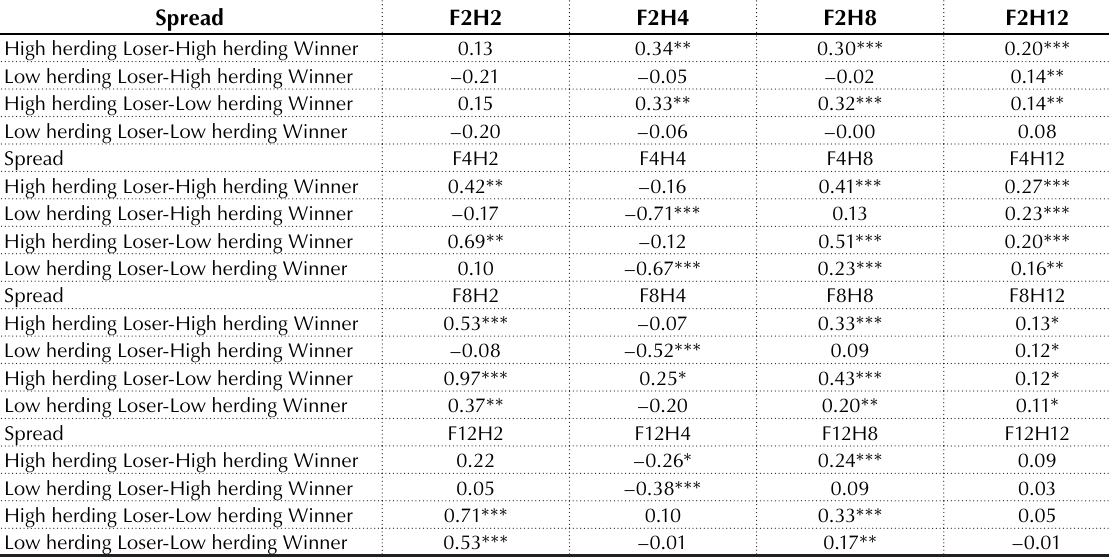
Table 4. Zero-cost portfolios